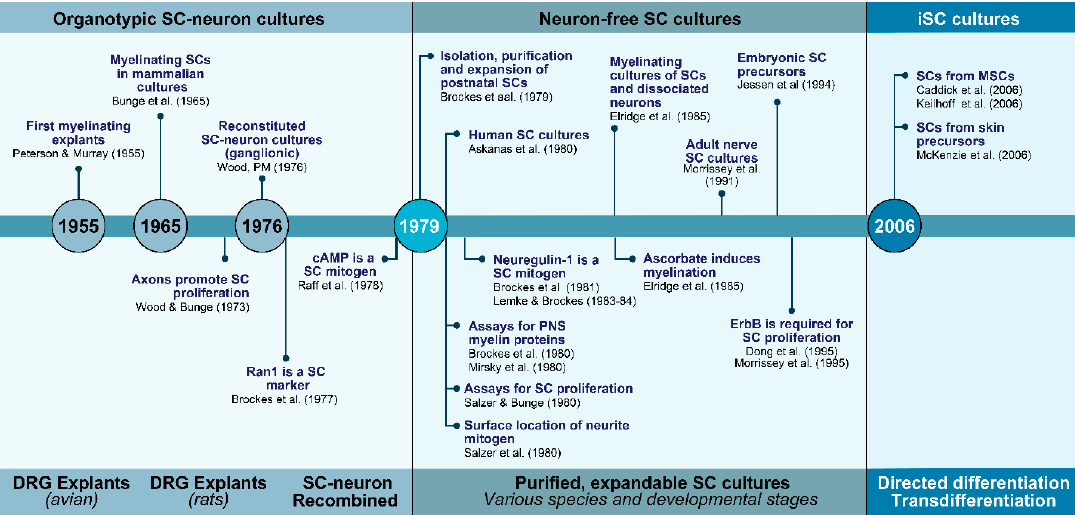
Figure 1. The evolution of SC cultures: from tissue culture to cell culture and beyond. The timeline summarizes some of the major technological and conceptual achievements by many contributing laboratories for over half a century. Main advancements facilitated the transition from culturing SCs within neural tissues (1960s and 1970s) to culturing SCs from neural tissues but in the absence of other cell types (1970s and 1980s). A new set of in vitro technologies are behind the creation of SCs from non-neural cells such as MSCs (2000s-). Some key innovations were represented in the timeline itself along with their references.